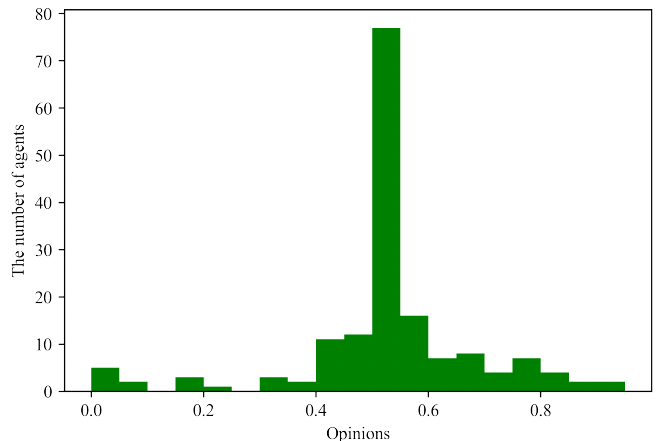
Figure 4. Distribution of sentiment values on the Suez Canal stranding.